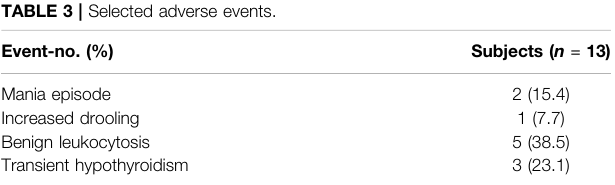
TABLE 3 | Selected adverse